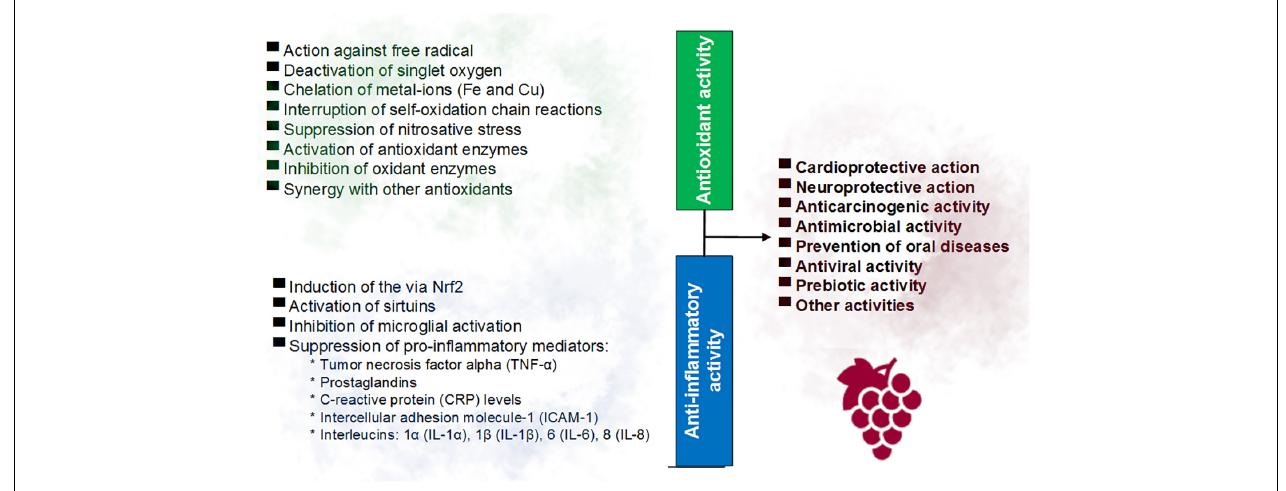
FIGURE 1 | Main involved mechanisms in the antioxidant and anti-inflammatory activities of the phenolic compounds of red wine. TABLE 1 | Some clinical studies on the effect of red wine on biomarkers of cardiovascular risk and related pathologies. Volunteers Red wine doses Main (study)